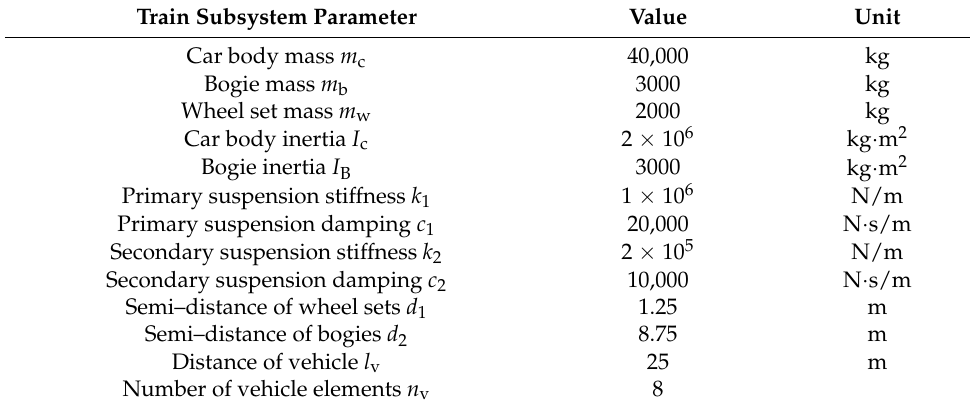
Table 1. Parameter values of the train subsystem